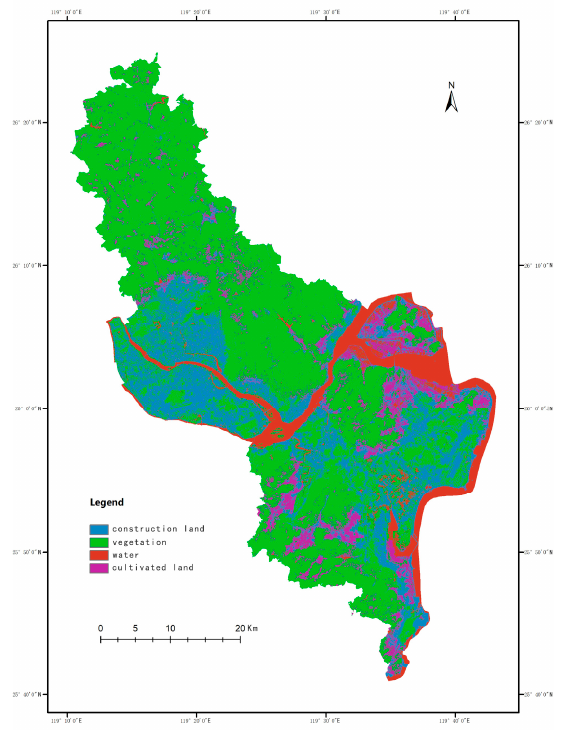
Figure 7. Land type of Fuzhou City.